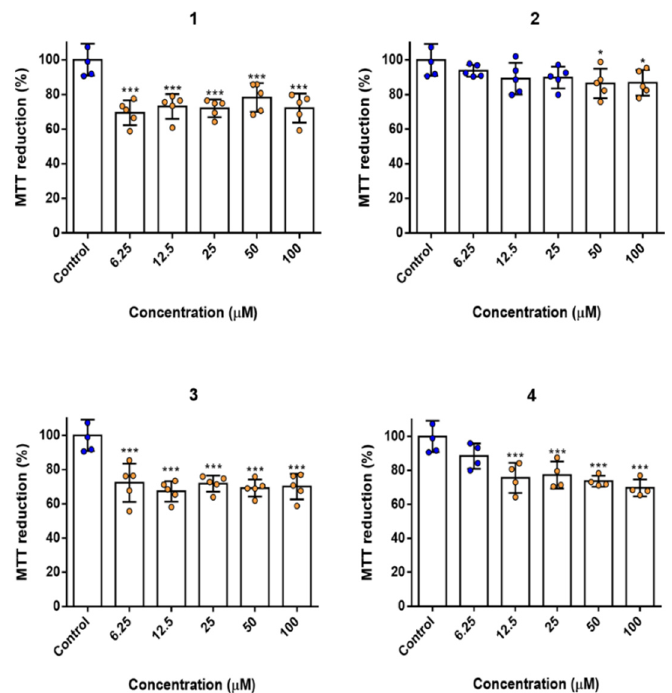
Figure 8. MTT reduction of HaCaT cells treated with compounds 1 , 2 , 3 , and 4 for 24 h, at the concentrations presented. * p < 0.05, *** p < 0.001.